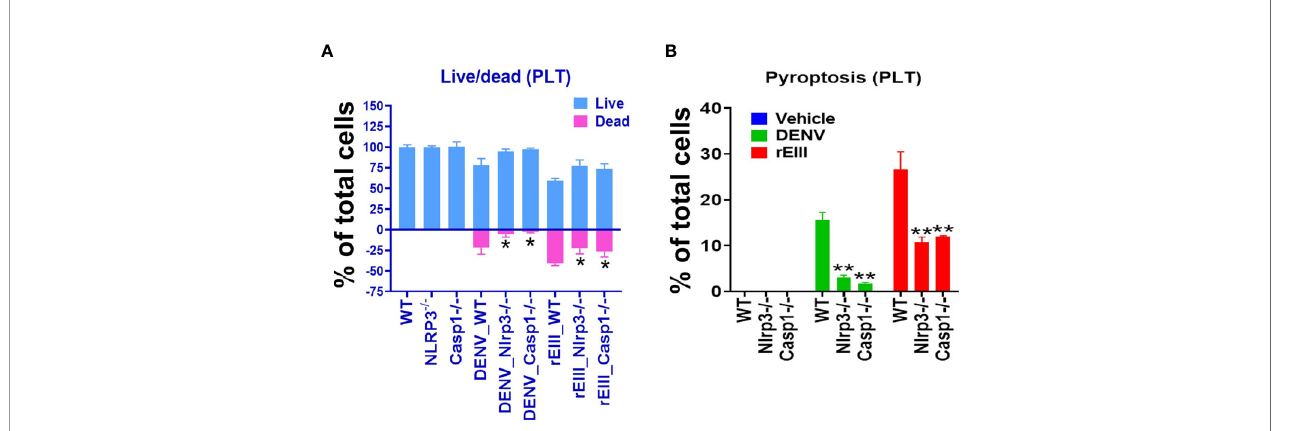
FIGURE 5 | Nlrp3 and caspase-1 de fi ciencies protect platelets from DENV (equivalent to 0.6 m M rEIII) - and rEIII (0.6 m M)-induced RCD. (A) Compared with wild type (WT) controls, platelets from Nlrp3 ( Nlrp3 − / − ) and caspase 1 ( Casp1 − / − ) de fi cient mice displayed less cell death levels in response to DENV and rEIII exposures. (B) Similar to the cell death analysis, platelets from Nlrp3 ( Nlrp3 − / − ) and caspase 1 ( Casp1 − / − ) de fi cient mice displayed less pyroptosis levels in response to DENV and rEIII challenges. n = 6, * P < 0.05, ** P < 0.01 vs. WT